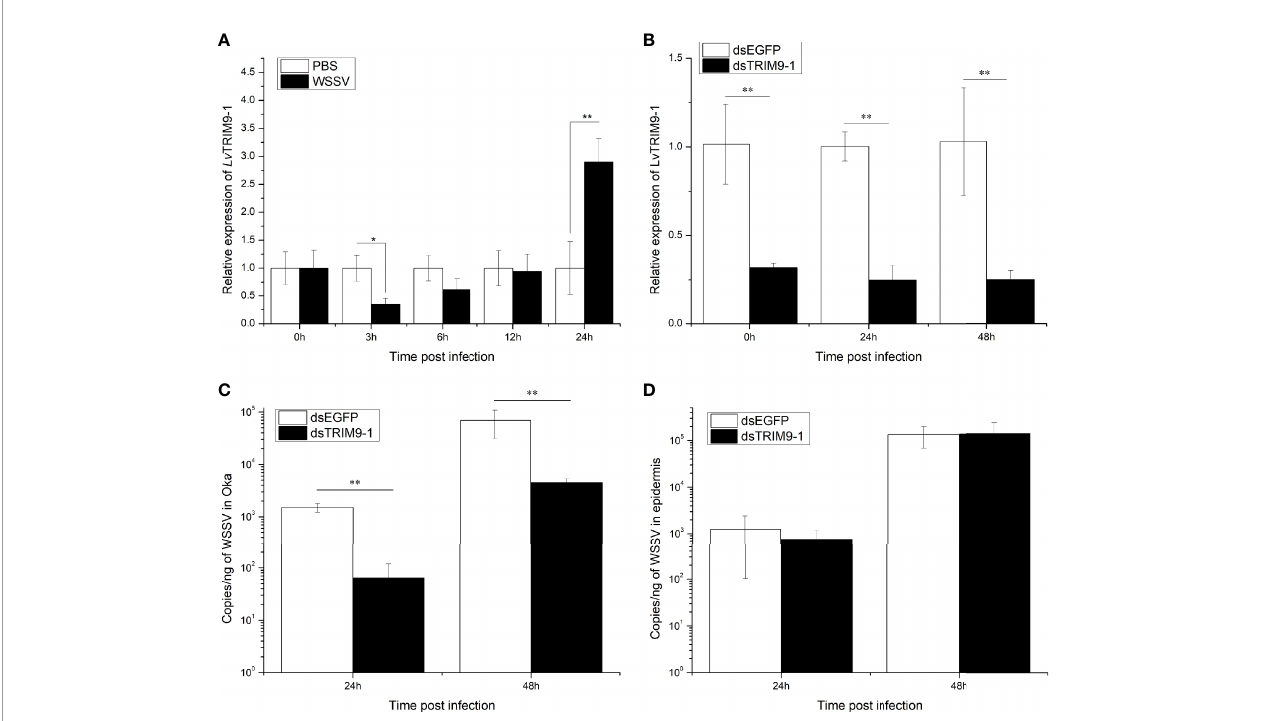
FIGURE 2 | LvTRIM9-1 is bene fi cial for WSSV infection in lymphoid organ. (A) Expression levels of LvTRIM9-1 in the lymphoid organ of shrimp at different time post-WSSV challenge. PBS stands for PBS injection group, and WSSV stands for WSSV injection group. (B) Inhibition ef fi ciency of LvTRIM9-1 dsRNA. Expression levels of LvTRIM9-1 in the lymphoid organ of LvTRIM9-1 silencing and control shrimp after 0, 24, and 48 h post WSSV infection. (C, D) Amount of WSSV particles in lymphoid organs and epidermis of shrimp at different hours after silencing of LvTRIM9-1 and WSSV infection. dsEGFP, injected with EGFP dsRNA and WSSV; dsTRIM9-1, injected with LvTRIM9-1 dsRNA and WSSV. Stars (*) indicate signi fi cant difference ( p < 0.05) and (**) indicate extremely signi fi cant difference ( p < 0.01) of the gene expression levels between the two treatments. All assays described above were biologically repeated for three